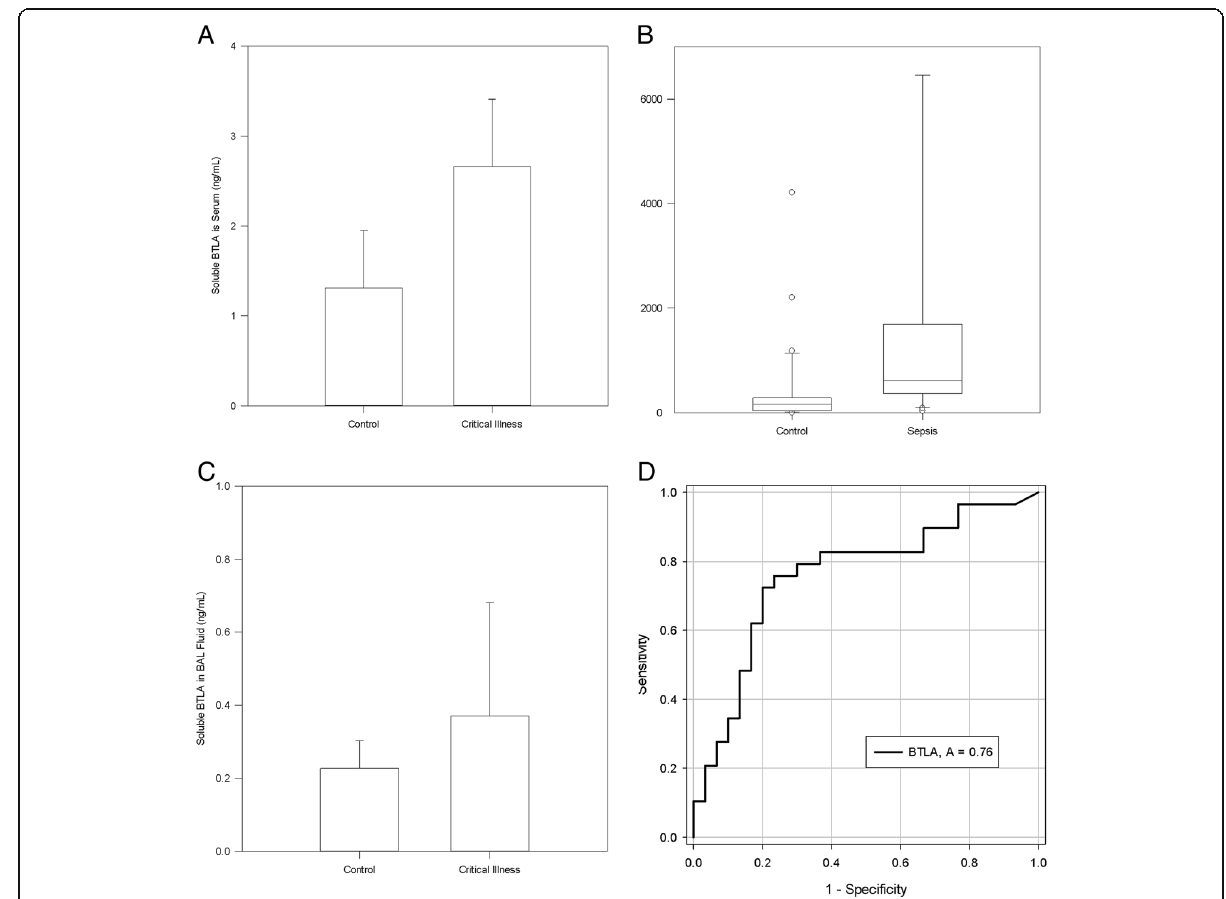
Fig. 1 – Soluble BTLA in Critical Illness: SBTLA is increased in the serum of mice (Figure a , p = 0.0037) and humans (Figure b , p < 0.001), but no differences were seen in the BAL fluid of mice ( p = 0.476, Figure c ), and changes in critically ill patient levels of sBTLA on day 0 of hospital admission predict the diagnosis of sepsis (Figure d